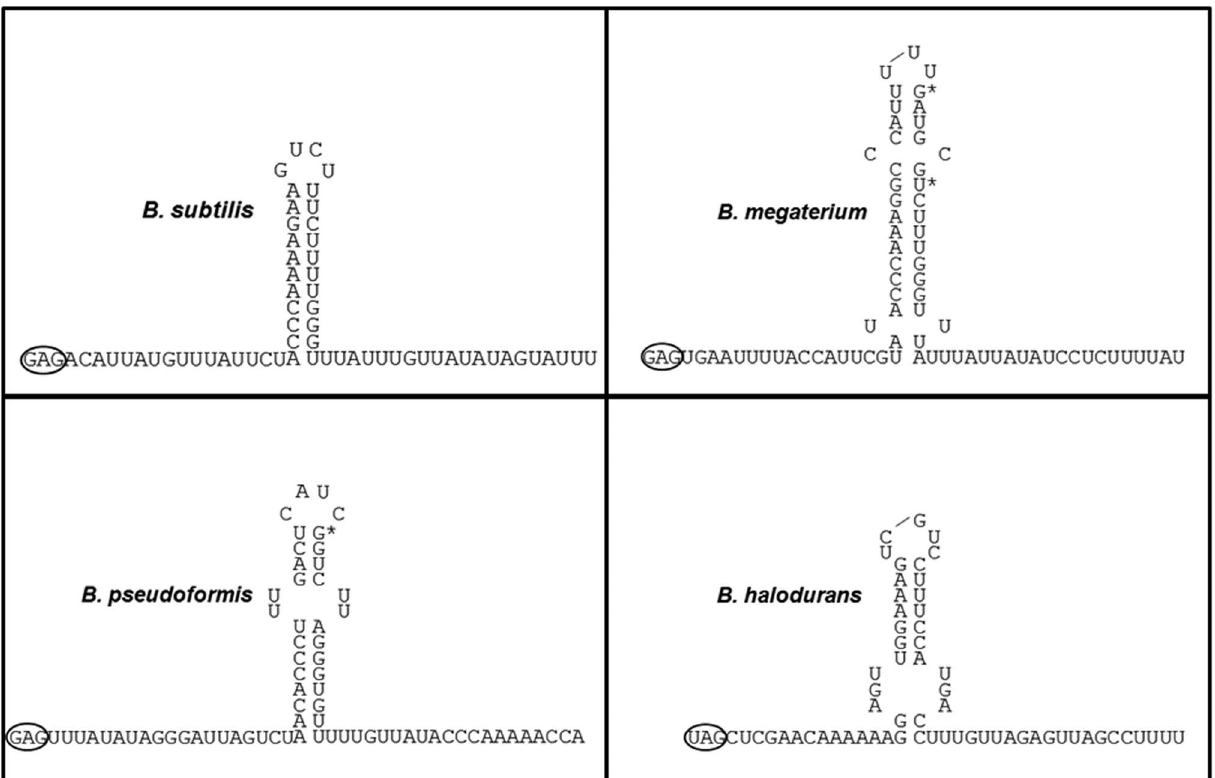
Figure 8. Trp attenuator regions of different bacterial species. Predicted attenuator RNA structures from the trp leader region of several TRAP containing bacterial species using M-fold [46]. The last repeat in the proposed TRAP binding is circled and the predicted attenuator structure is shown as well as 20 residues downstream of the predicted base-paired stem.